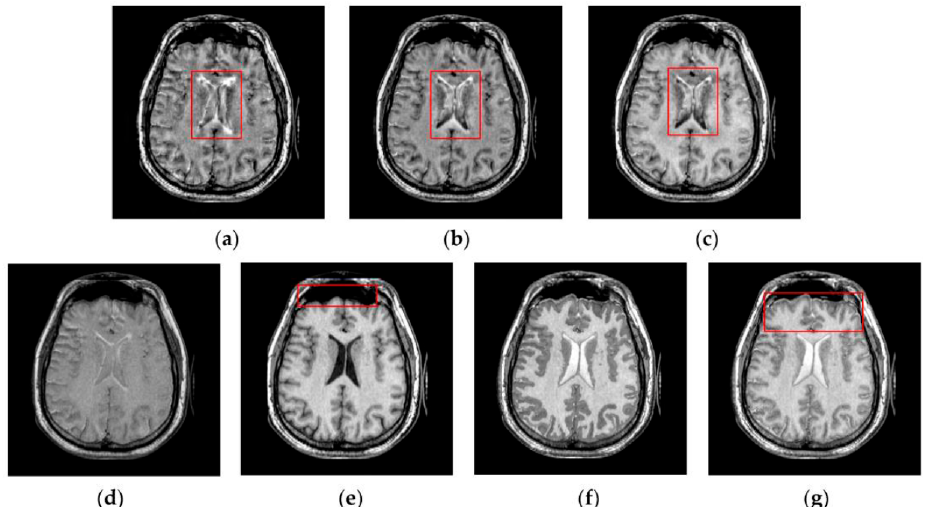
Figure 9. Fused results of the evaluated methods for the fourth group of source images shown in Figure 6g,h: ( a ) the DWT method; ( b ) the NSCT method; (c) the NSCT-SR method; ( d ) the m-PCNN method; ( e ) the PCNN-NSCT method; ( f ) the SCM-F method; and ( g ) the SCM-M method.